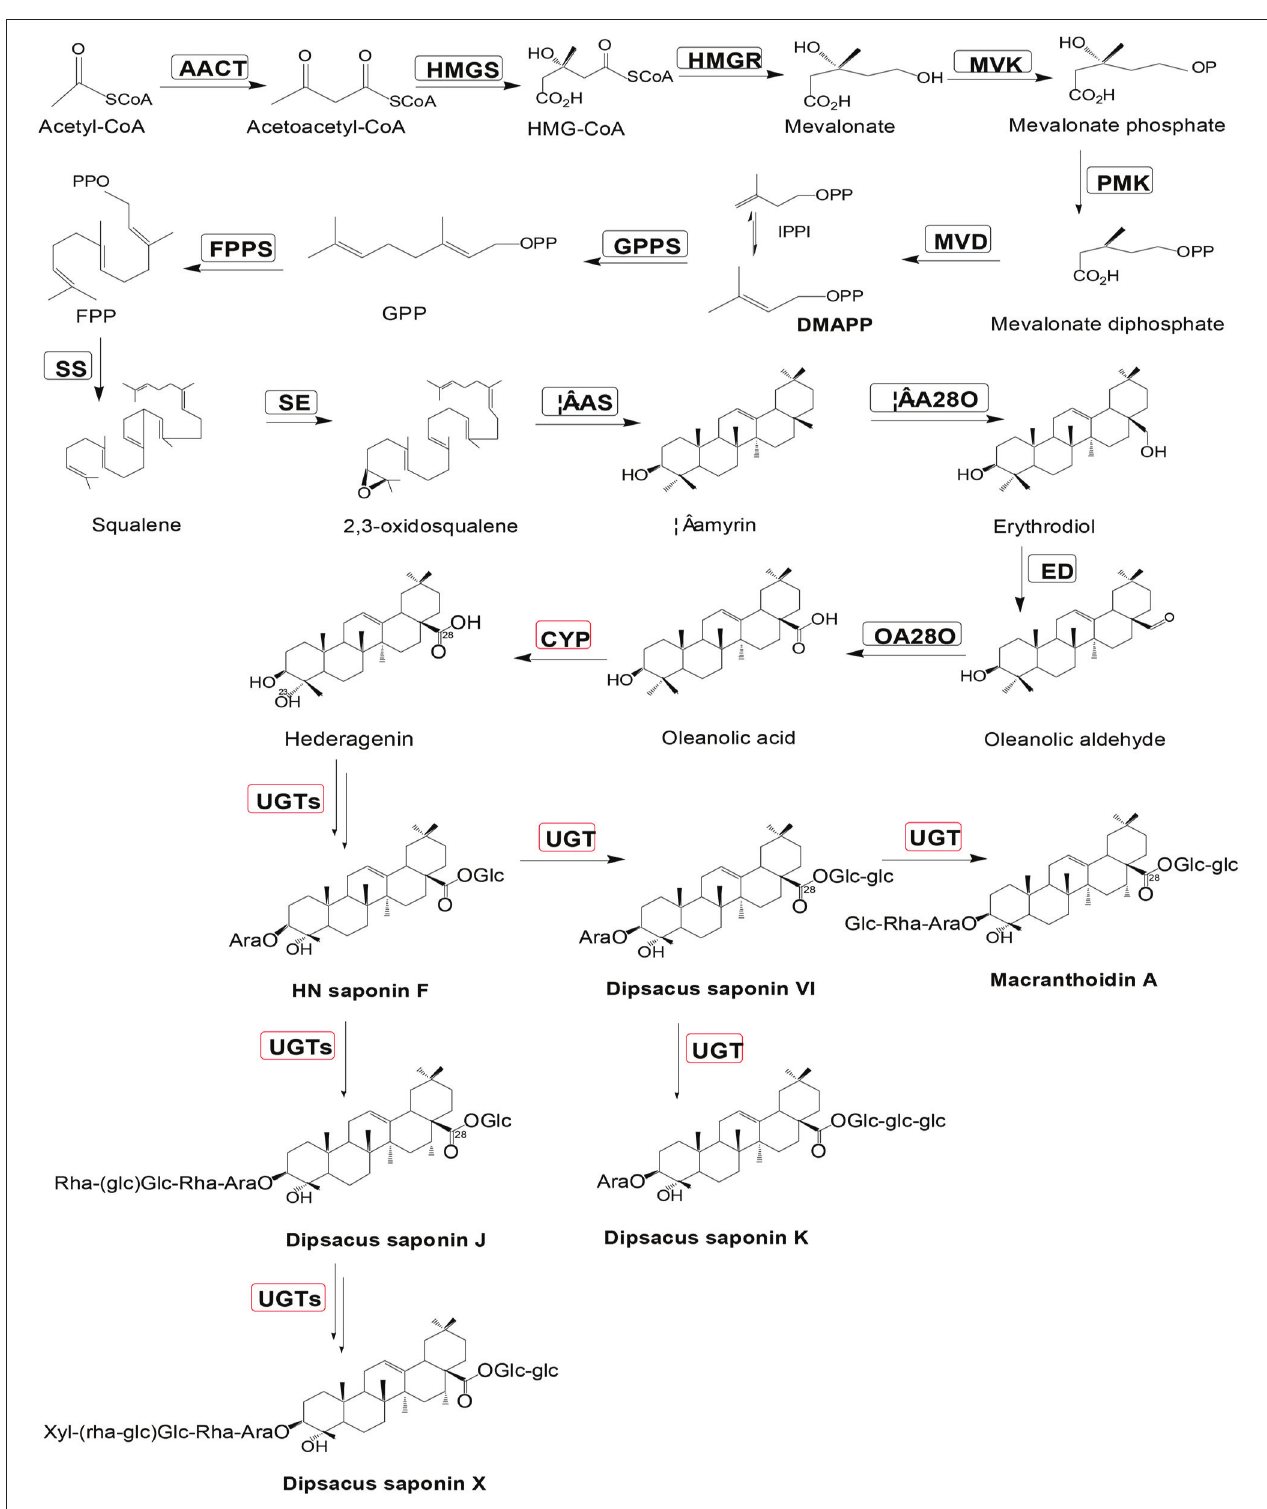
FIGURE 1 | Putative Dipsacus saponin VI biosynthesis pathway in D. asperoides . Enzymes found in earlier studies are surrounded by a black box; new putative enzymes are surrounded by a red box. Enzymes involved in the pathways are: AACT, acetyl-CoA acetyltransferase; HMGS, hydroxymethylglutaryl-CoA synthase; HMGR, hydroxyl methylglutaryl-CoA reductase; MVK, mevalonate kinase; PMK, phosphomevalonate kinase; MVD, mevalonate diphosphate decarboxylase; GPPS, geranylgeranyl pyrophosphate synthase; FPPS, farnesyl diphosphate synthase; IPPI, isopentenyl diphosphate isomerase; SS, squalene synthase; SE, squalene epoxidase; β -AS, β -amyrin synthase; and β -A28O, β -amyrin 28-monooxigenase.